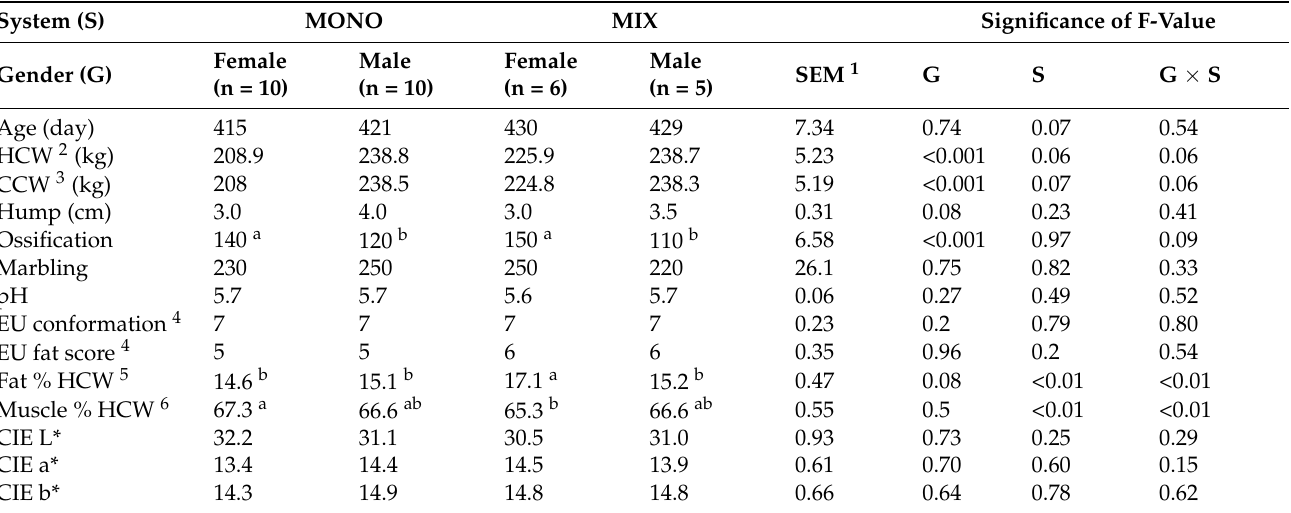
Table 2. Estimated marginal means of animal and carcass characteristics as affected by animal gender and farming